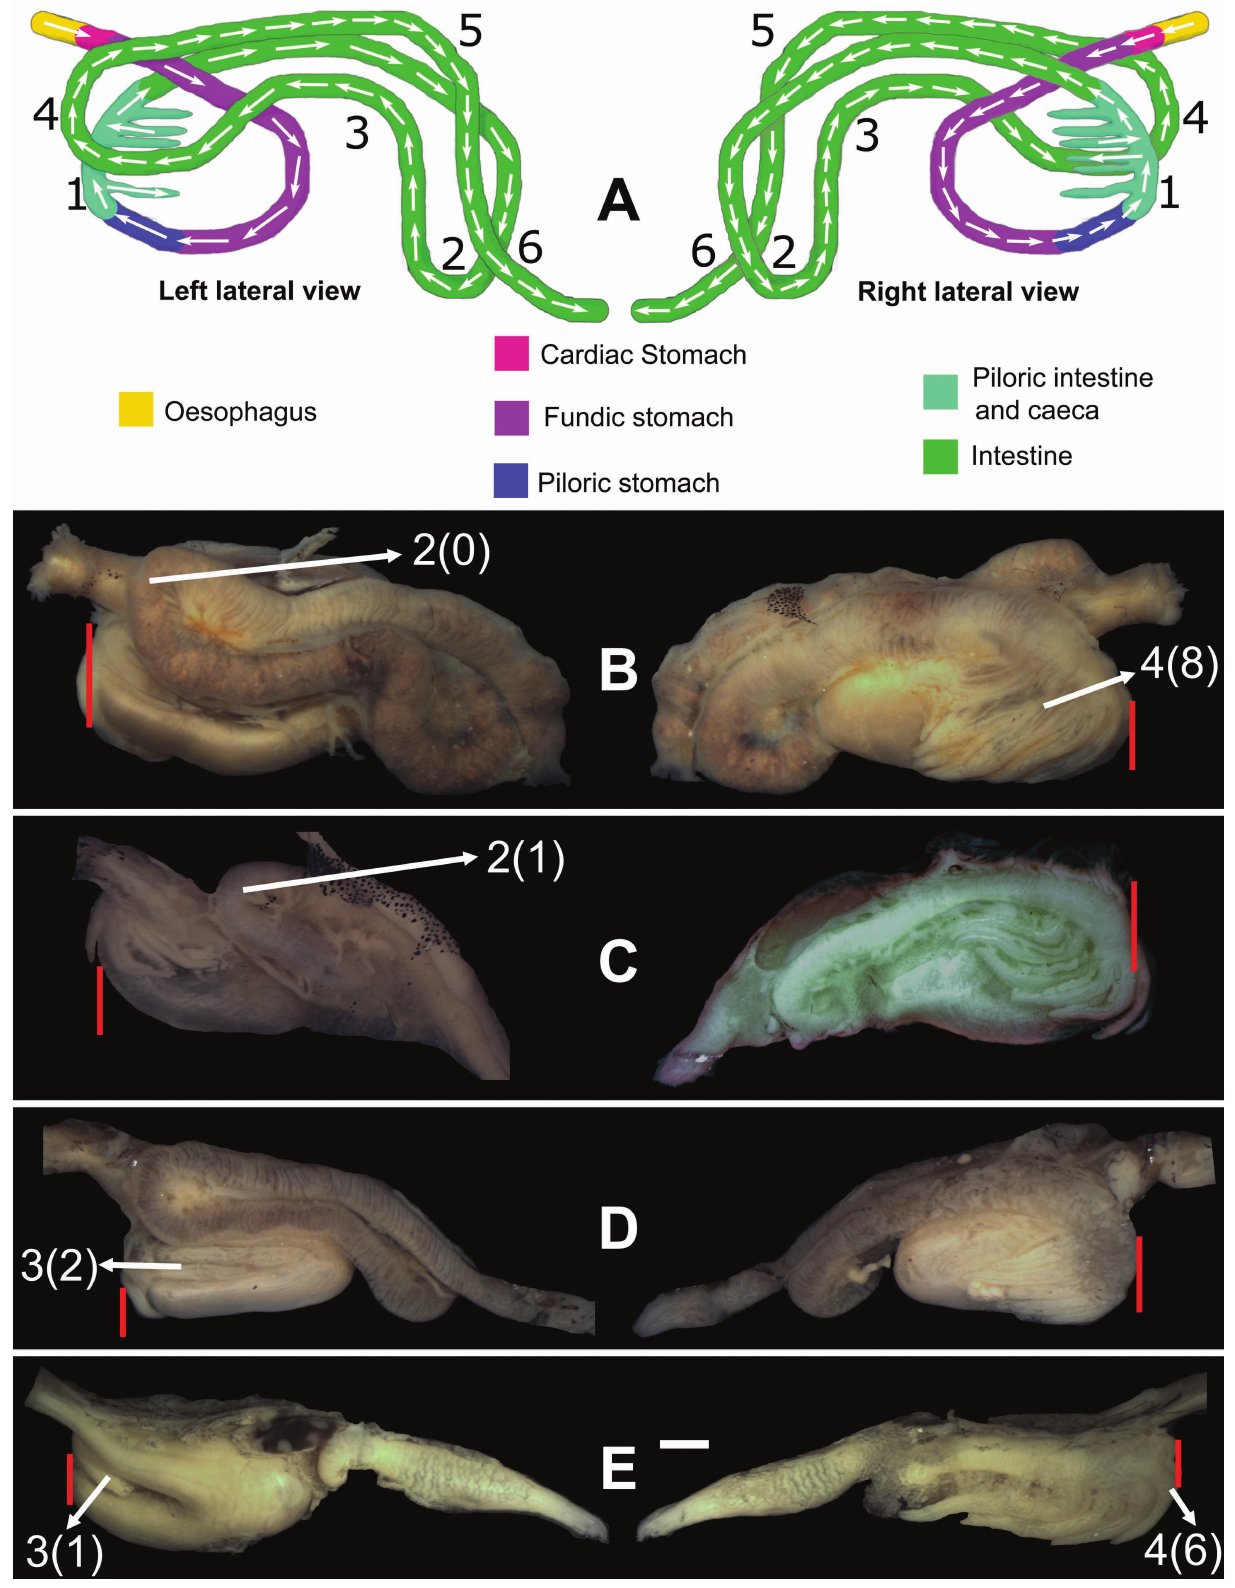
Fig. 1. Alimentary tract of selected species of the Characidae family: A - Schematic representation of the alimentary tract; B - Astyanax endy ; C - Astyanax rutilus ; D - Cheirodon interruptus ; E - Aphyocharax anisitsi. Characters are indicated with numbers and character states between parentheses. Red bar indicates the anterior distal margin of the stomach.